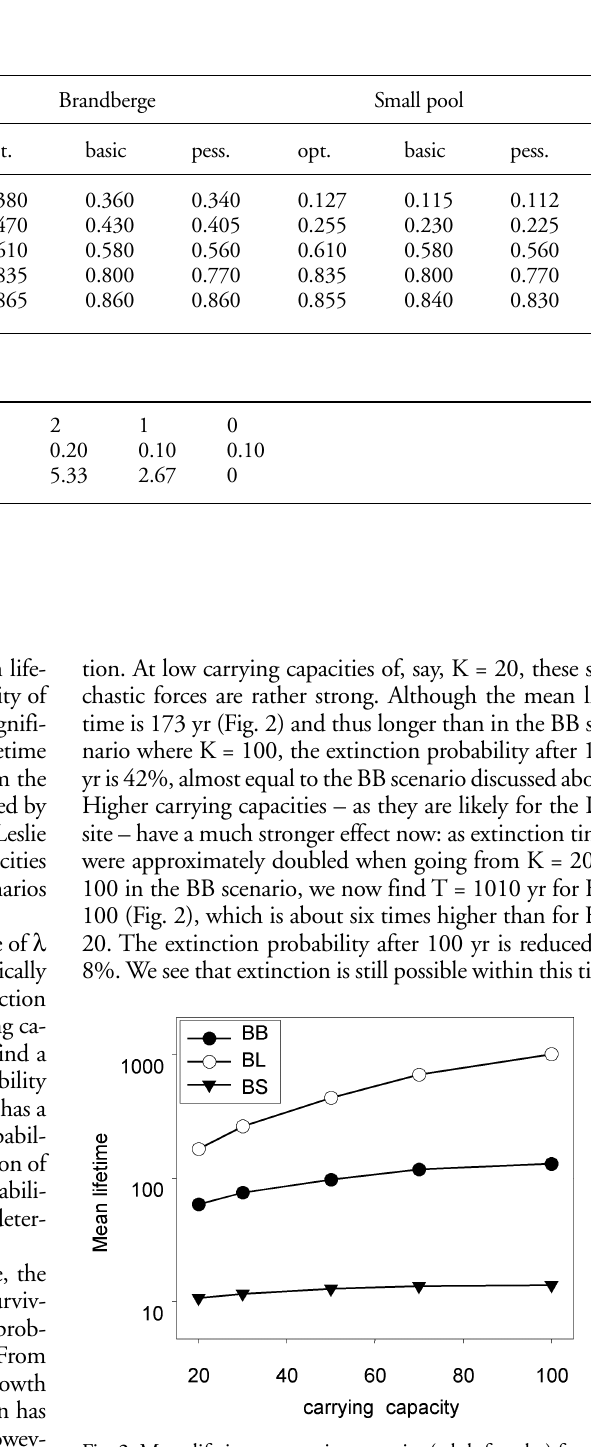
Fig. 2. Mean lifetime vs carrying capacity (adult females) for nat- terjack toad populations in three different locations, namely “List” (BL), “Brandberge” (BB) and “Small pool”